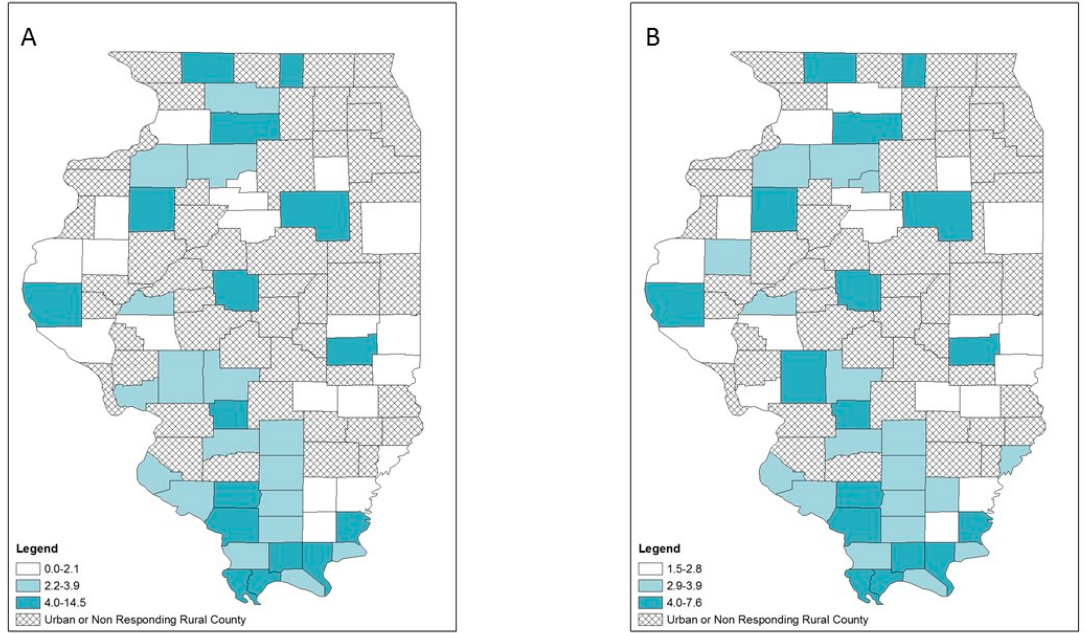
Figure 6. HIV diagnosis rates per 100,000 population by tertiles, respondent rural counties, Illinois, 2010–2017: ( A ) crude rates; ( B ) empirical Bayes estimated rates.